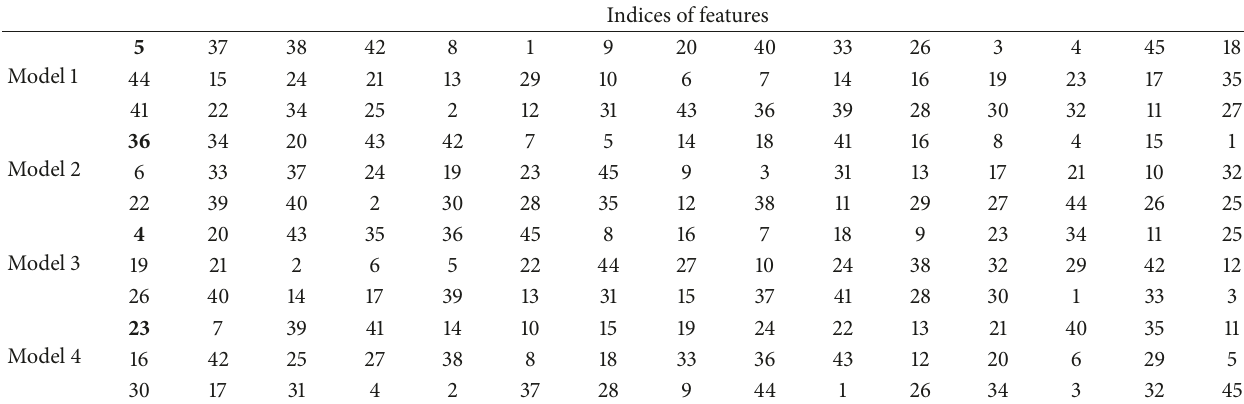
Table 2: RFWF results of the feature set in different models of the classifier.